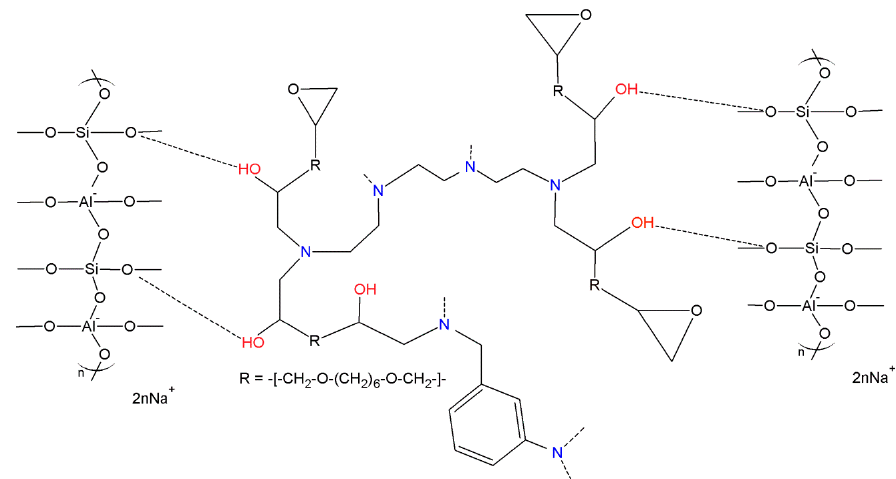
Figure 2. Schematic representation of some possible interactions between the epoxy resin Epojet ® [31] (in the middle) and the geopolymeric matrix (on the left and the right, in the hypothesis of Na/Al = 1:1). Dashed lines represent hydrogen bonds.